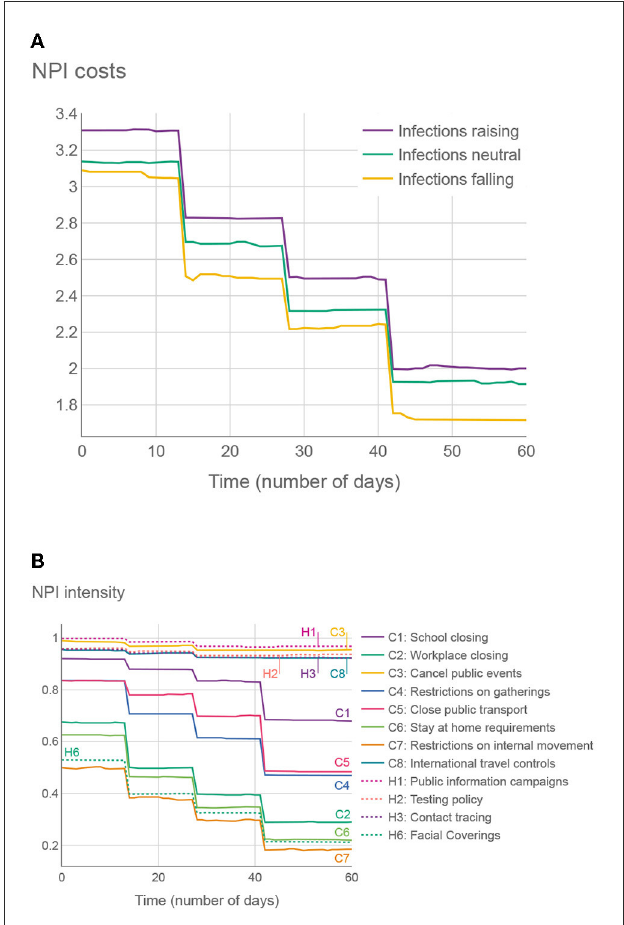
FIGURE7 (A) Average SEC across all 500 proposed intervention plans (50 test cases, 10 plans on each), given the number of days since the intervention has started. (B) Average OxNPI strictness (normalized to 0-1 range) across all 500 proposed intervention plans, given the number of days since the intervention has